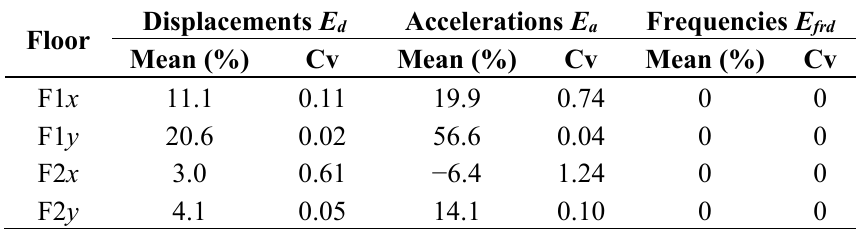
Table 4. Average (Mean) and coefficient of variation (Cv) of percentage errors (linear analyses). Displacements E Floor